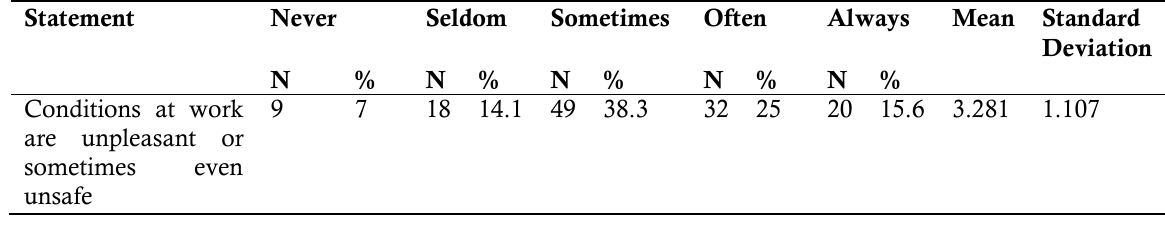
Table 6 <Descriptive of the Psychological